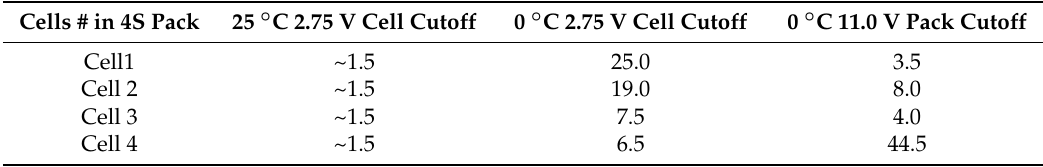
Table 2. Capacity loss (%) for cells within 4S pack after 50 charge/discharge